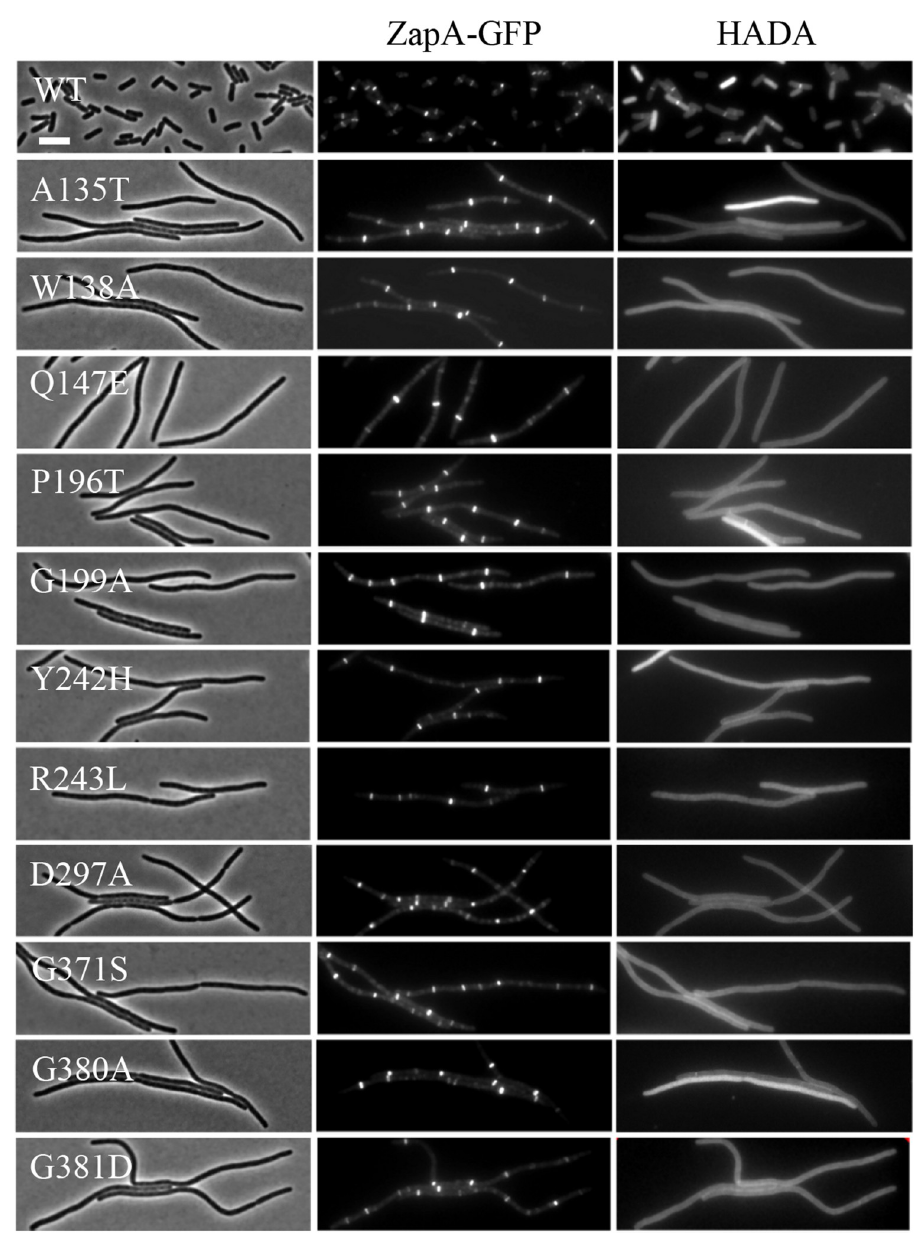
Fig 8. Overexpression of the dominant-negative FtsW mutants blocks septal PG synthesis. Overnight cultures of HC261 (TB28, zapA-gfp ) carrying plasmid pSEB429 or its derivatives were diluted 1:100 in fresh LB medium with antibiotics and cultured at 30˚C. 2 hours later the cultures were diluted 1:10 and IPTG was added to a final concentration of 200 μ M to induce the expression of the FtsW mutants. 2 hours post induction, a 200 μ l sample was taken from each culture and incubated with 2 μ l of HADA (final concentration, 0.25 mM) in dimethyl sulfoxide (DMSO) for 1min followed by fixation with paraformaldehyde and glutaraldehyde for 15 min on ice. Cells were then washed five times with phosphate-buffered saline (PBS) and resuspended in 50 μ l of PBS and spotted onto an agarose pad for imaging. Scale bar, 3 μ m.